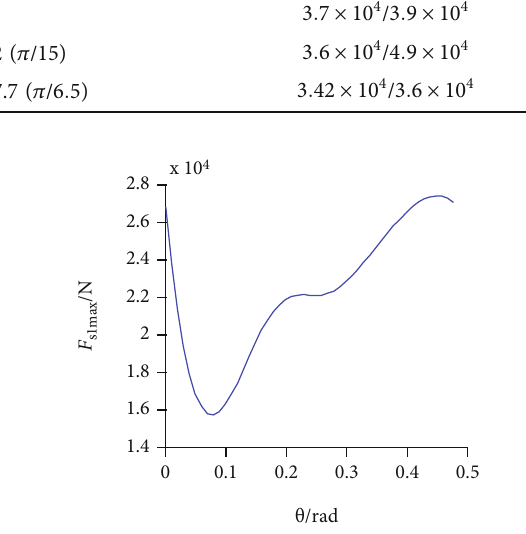
Table 15: Impact on the maximum force of the primary strut under typical lunar inclination conditions. Lunar inclination ( °